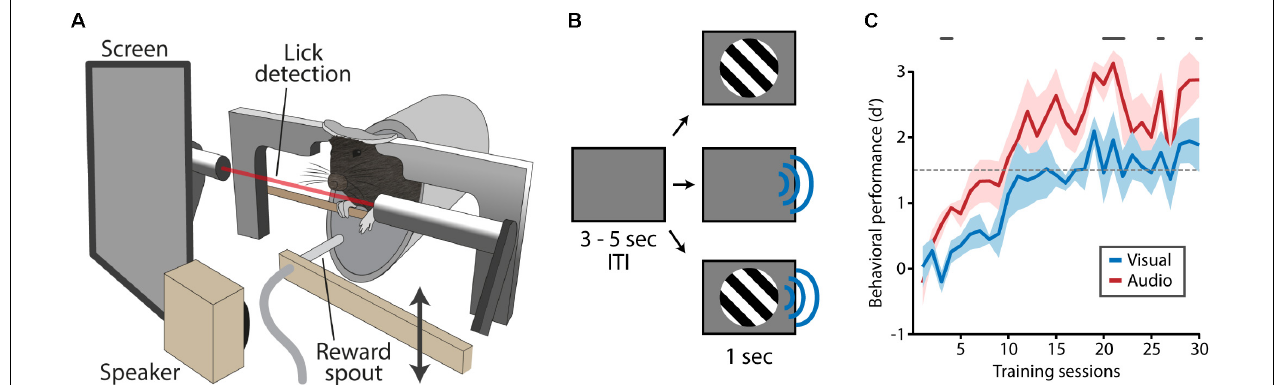
FIGURE 1 | Training apparatus and task design. (A) Mice were positioned in the training apparatus with their heads fixed and their body in a body holder. Visual stimuli were presented on a screen located in front of the right eye, auditory stimulation was delivered through a speaker next to the screen. An infra-red beam in front of the mouth enabled the detection of licks. A reward spout, which was out of reach during most of the trial, was moved toward the mouse’s mouth at times reward was dispensed. (B) A trial started with an inter-trial interval (ITI) during which a gray isoluminant screen was shown. Following the ITI, visual, auditory or audiovisual stimuli were presented. (C) During task acquisition mice were trained to respond to visual and auditory stimuli (no audiovisual stimuli) which typically took 15–20 days after which task performance was on average above the performance criterion of d (cid:48) = 1.5 (dashed gray line). Mice responded with more fidelity to auditory compared to visual stimuli as indicated by a significantly higher d-prime (gray lines above plot indicate significant differences, Matched Pairs Signed Rank Test, p <